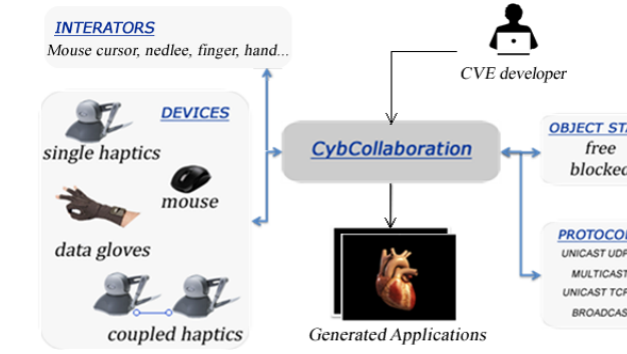
Fig. 4: Integration of CybCollaboration features.